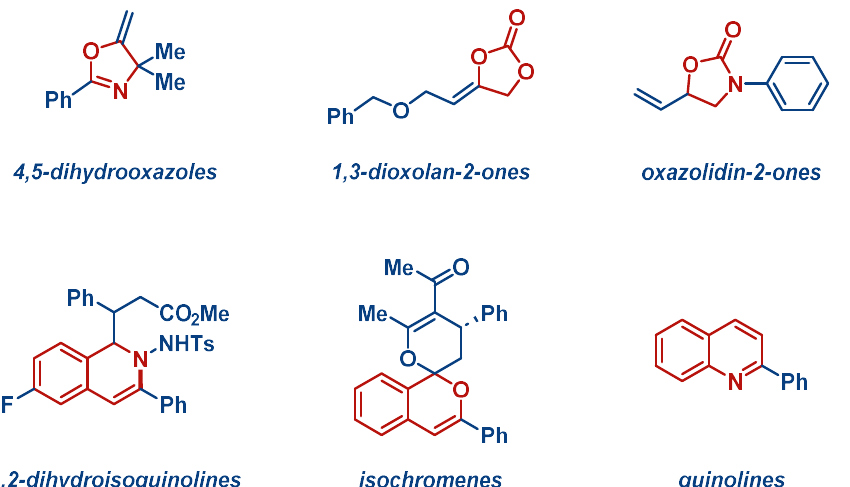
Figure 2. Heterocyclic scaffolds (4,5-dihydrooxazoles [59,64,85]; 1,3-dioxolan-2-ones [61,86]; oxazolidin-2-ones [76,87]; 1,2-dihydroisoquinolines [70,88]; isochromenes [71,89]; quinolines [72,90]; synthesized by Ag(I)−NHC complexes.